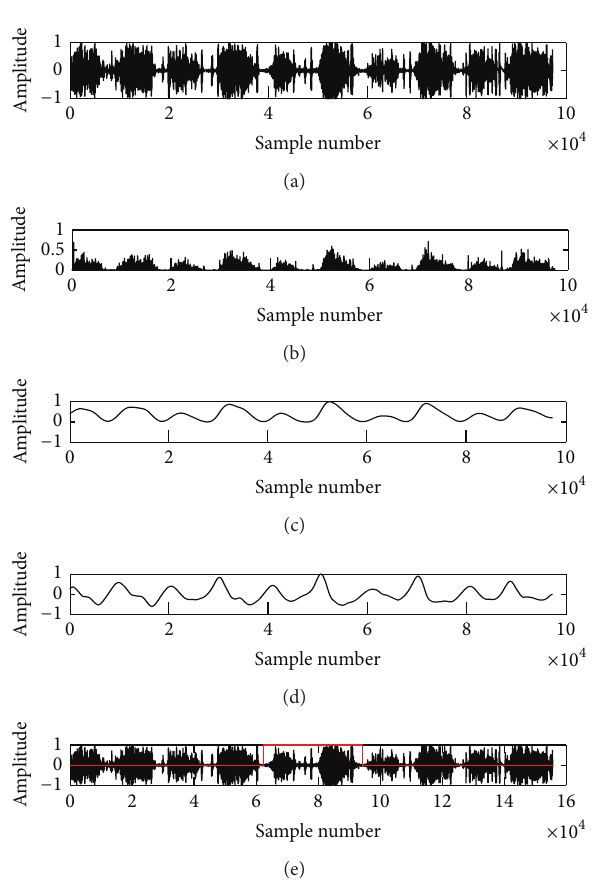
Figure 4: (a) depicts the waveform of a normal LS signal. (b) It shows the Hilbert envelope and (c) shows the smoothen envelope. (d) First order derivative of the smoothen envelope curve. (e) The red line defined a respiratory cycle estimated by the distance between two consecutive